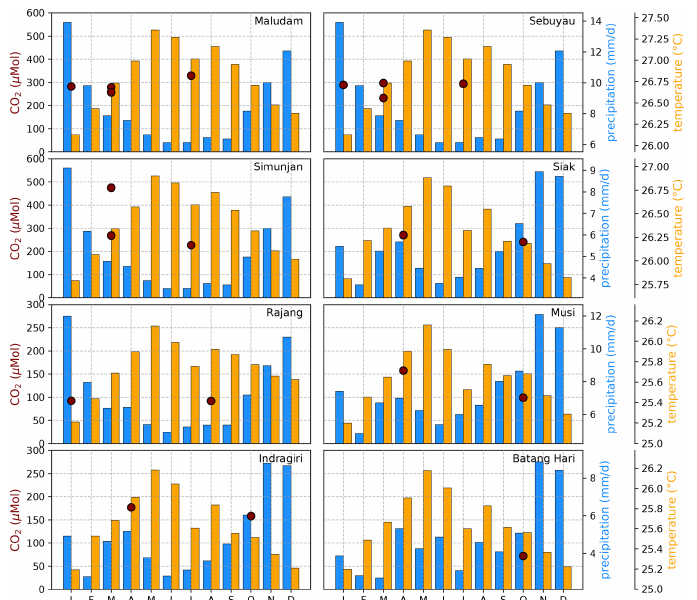
Figure B4. Average CO 2 concentrations for individual campaigns compared to monthly temperature (Natawa, 2018a; Yasutomi et al., 2011) and precipitation (Natawa, 2018b; Yatagai et al., 2020) data (2005–2015 average) at the location of the respective river. Each panel represents one river.